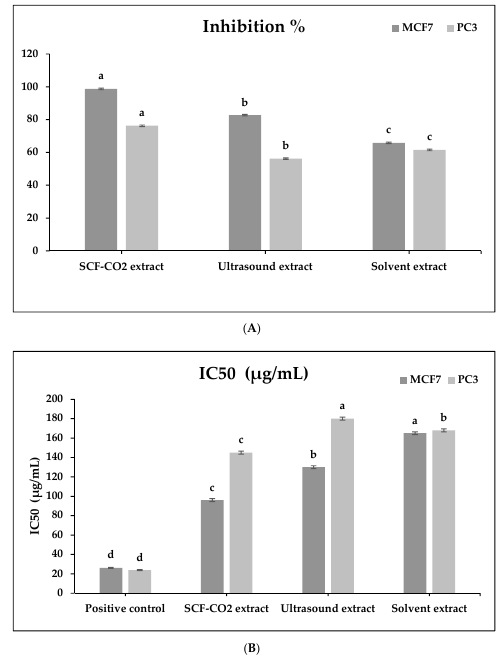
Figure 4. ( A ) and ( B ) Anticancer effect of Cassia javanica petals extract treated by ethanol, ultrasound, and SCF-CO 2 . IC 50 : Lethal concentration of the sample which causes the death of 50% of cells in 48 h; PC3: Prostate cell line; MCF7: Human Caucasian breast adenocarcinoma, Positive control Adriamycin (Doxorubicin). a–d different superscripts in a column were significantly different ( p < 0.05); data are means ± S.D. ( n =